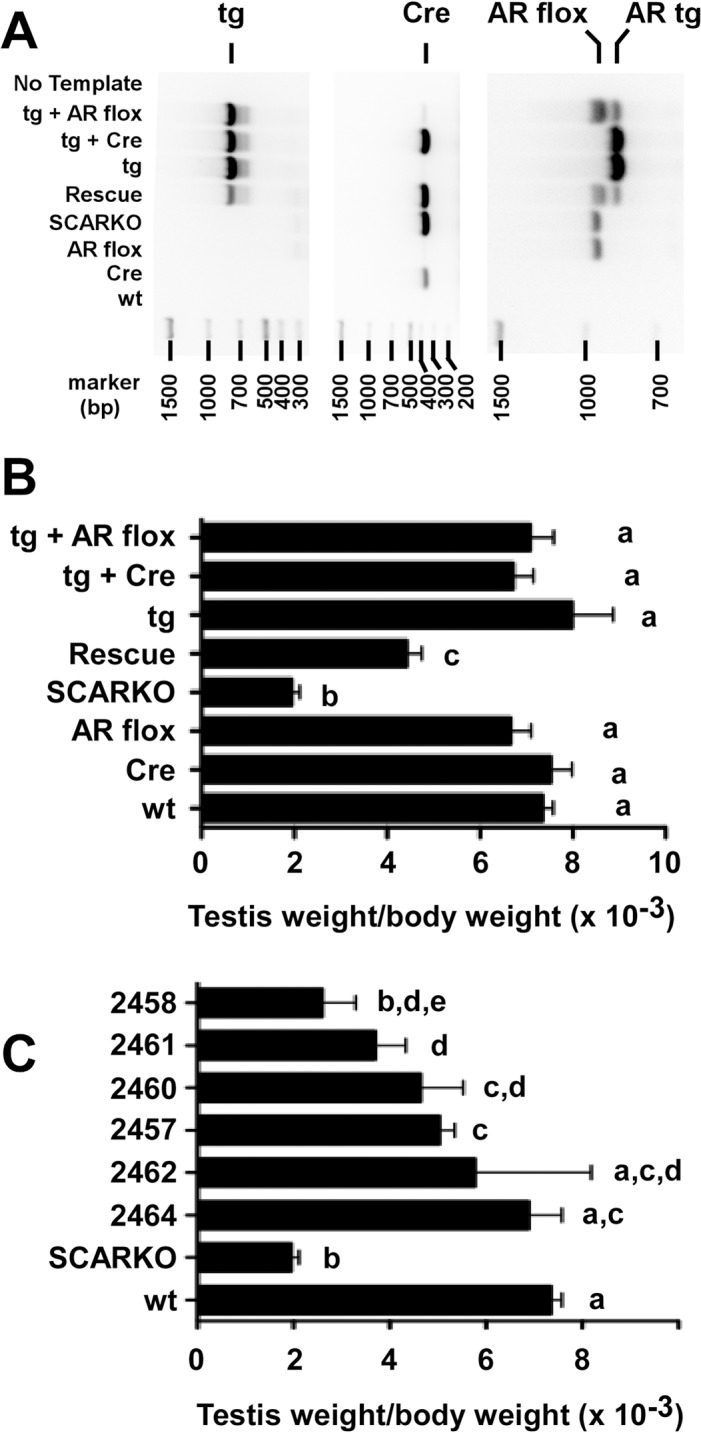
The AR-EGFP transgene increases testis weights in rescue mice.A) Agarose gel analysis is shown of PCR reactions used to genotype mice employed primers that identify the AR-EGFP transgene (tg), the Cre recombinase (Cre) or floxed endogenous AR (AR flox) and the AR transgene (AR tg). Mouse strains were identified that expressed no transgenes (wild type, wt), the Cre recombinase (Cre), a floxed AR gene (AR flox) as well as SCARKO and rescue mice. Mice expressing the AR-EGFP transgene (tg), the transgene + Cre (Tg + CRE) or the transgene in the presence of a floxed AR gene (Tg + AR flox) also were identified. The sizes of DNA markers in base pairs (bp) are shown below each gel image. B) Testis weight/body weights are provided for mice expressing the transgenes as described in A. C) The testis weight/body weight for the individual rescue mouse strains are shown relative to the same wt and SCARKO values used in panel B. Values with different lowercase letters differ significantly (P<0.05). Panel B, n = 6 to 39, panel C, n = 3 to 14).